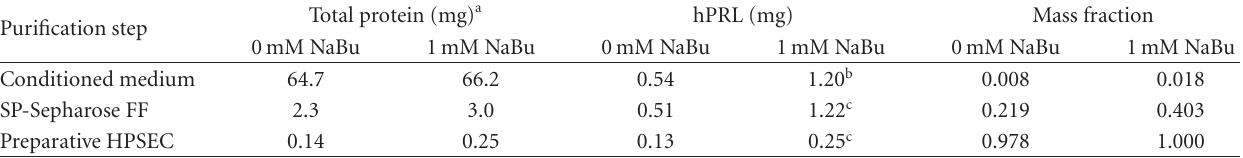
Table 2: Recombinant hPRL purification starting from 500 mL of NaBu-treated or untreated CHO-conditioned medium. Total protein (mg) a Purification step Conditioned medium 64.7